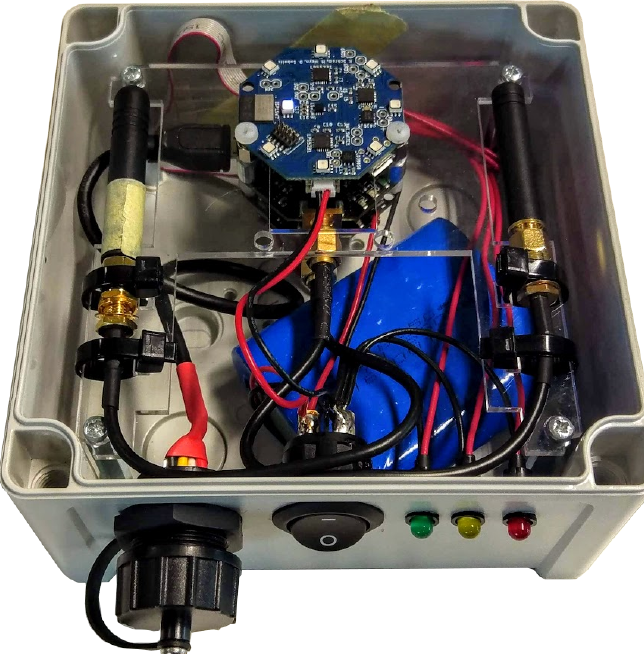
Figure 1. A photograph showing the inside of a regular network node. It contains two OCTA-mini transceivers for respectively 433 MHz and 868 MHz communication attached to two antennas and a 6600 mAh